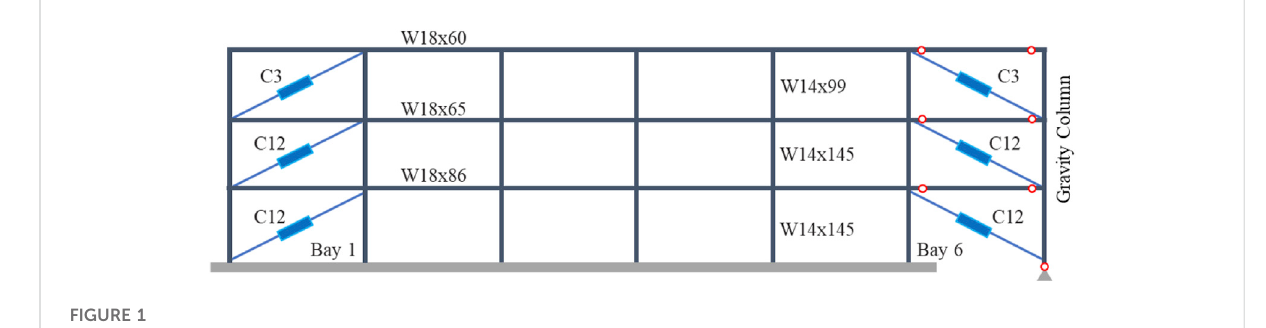
FIGURE 1 Con fi guration of the VDMF.